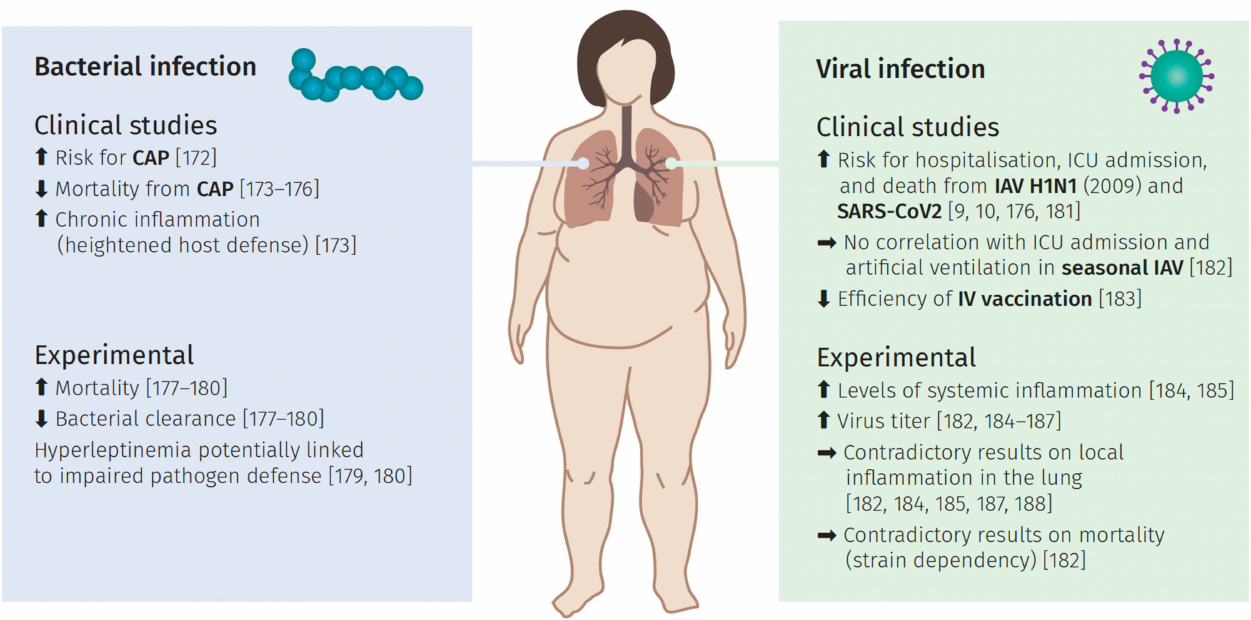
Figure 4. The impact of obesity and bacterial and viral infections. Overview of observations gained from clinical studies and experimental approaches regarding bacterial and viral infections in obese subjects with corresponding